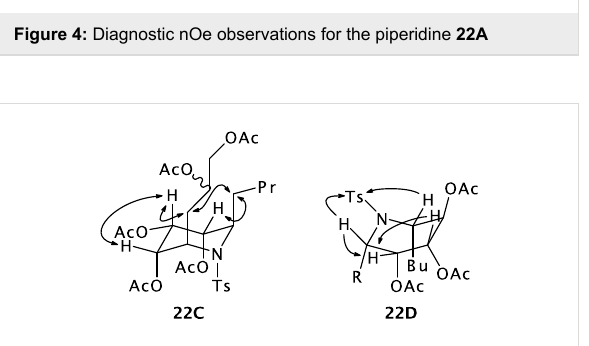
Figure 3: Diastereoselective dihydroxylation of unsaturated piperidines The dihydroxyation of the anti allylic alcohol 19 under Upjohn conditions was not synthetically useful (entry 8a, Table 1).